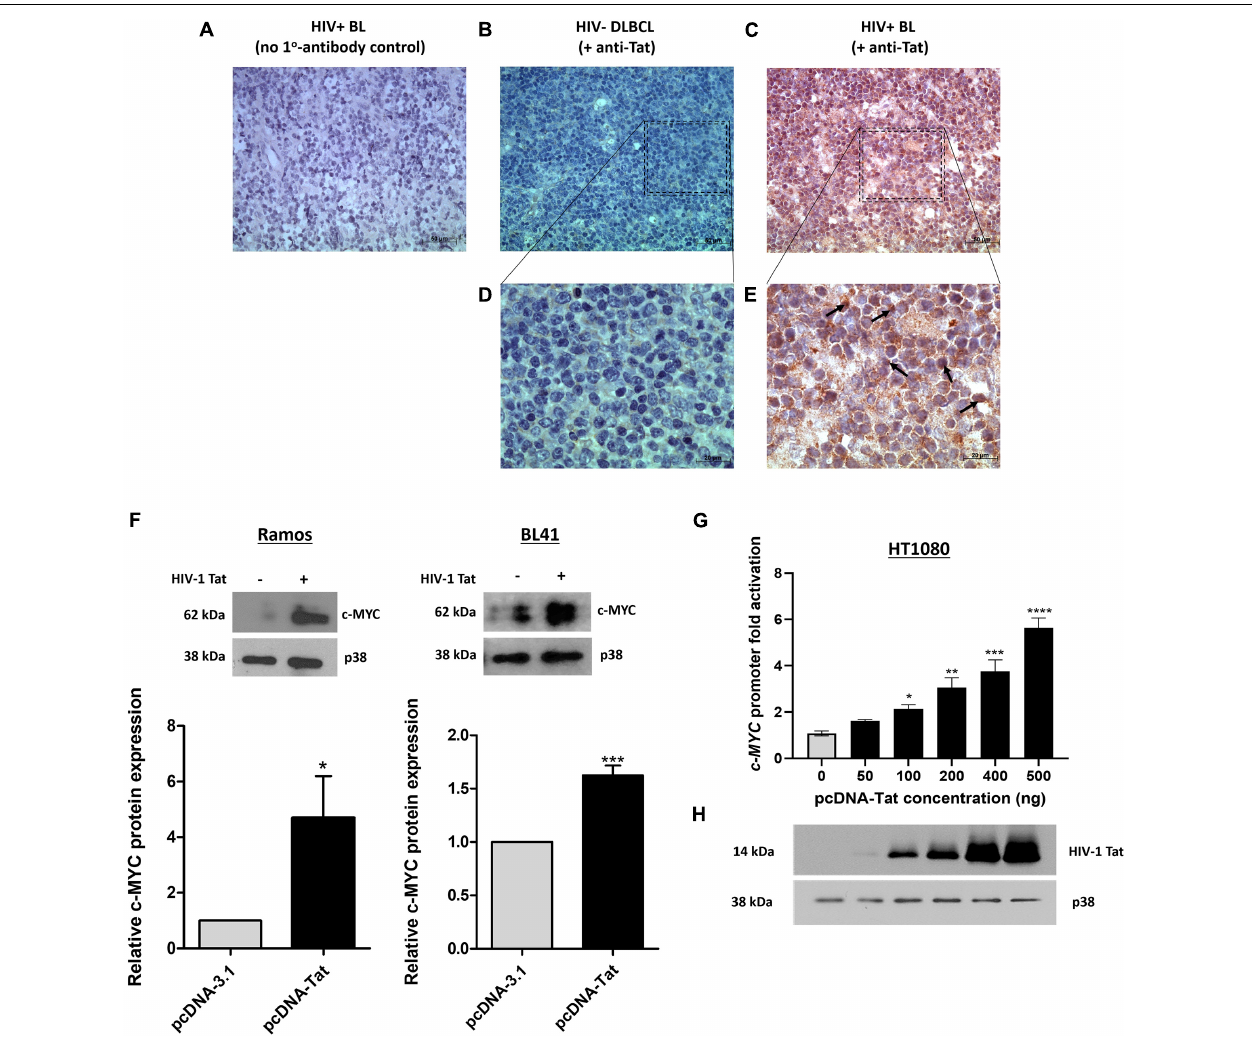
FIGURE 1 | HIV-1 Tat is detected in BL tumor tissue and elevates c-MYC expression at the transcriptional and translational levels. (A–E) Immunohistochemical detection of Tat protein in FFPE tumor samples from lymphoma patients. An HIV positive BL incubated without primary antibody (replaced with buffer only) (A) and an HIV negative DLBCL incubated with primary Tat antibody (ab43014, Abcam, United Kingdom) as used for the HIV positive BL tumor samples (B) , were used as controls. (C) IHC for Tat protein expression in HIV positive BL tumor tissue. Positive staining is indicated by deposition of DAB (brown) and Hematoxylin was used as counterstain (blue/purple). Distinct nuclear Tat expression (marked by black arrows in E ). Images (A–C) were taken at 400X magnification and (D,E) at 1000X. Scale bar in (A–C) represents 50 and 20 µ m in (D,E) . (F) Western blotting of total proteins isolated from Ramos (Left) and BL41 (Right) cells electroporated with pcDNA-Tat expression vector or pcDNA-Empty control using anti-c-MYC (SC-764, Santa Cruz Biotechnology, United States) antibody. Anti-p38 (M0800, Sigma-Aldrich, United States) was used as a loading control. Bar graphs represent densitometric analysis of western blots (ImageJ) and error bars represent standard deviation (SD). (G) Dual-Luciferase Reporter assay shows a significant dose-dependent increase in c-MYC promoter activity with increasing HIV-1 Tat concentration, relative to the empty-vector control which has been set at 1. The following fold increases were obtained for the indicated pcDNA-Tat concentrations: 50 ng: 1.5 ± 0.15; 100 ng: 2 ± 0.03; 200 ng: 2.86 ± 0.2; 400 ng: 3.5 ± 0.2 and 500 ng: 5.3 ± 0.02. Error bars represent SD. (H) Western blot showing increasing expression of HIV- 1 Tat in transfected HT1080 cells in G, with p38 as a loading control. Statistical analysis was done using GraphPad PRISM 8 with Student’s t -test and one-way ANOVA, significance indicates ∗ ( p < 0.05), ∗∗ ( p < 0.01) ∗∗∗ ( p < 0.001), ∗∗∗∗ ( p < 0.0001). The results are representative of at least three separate